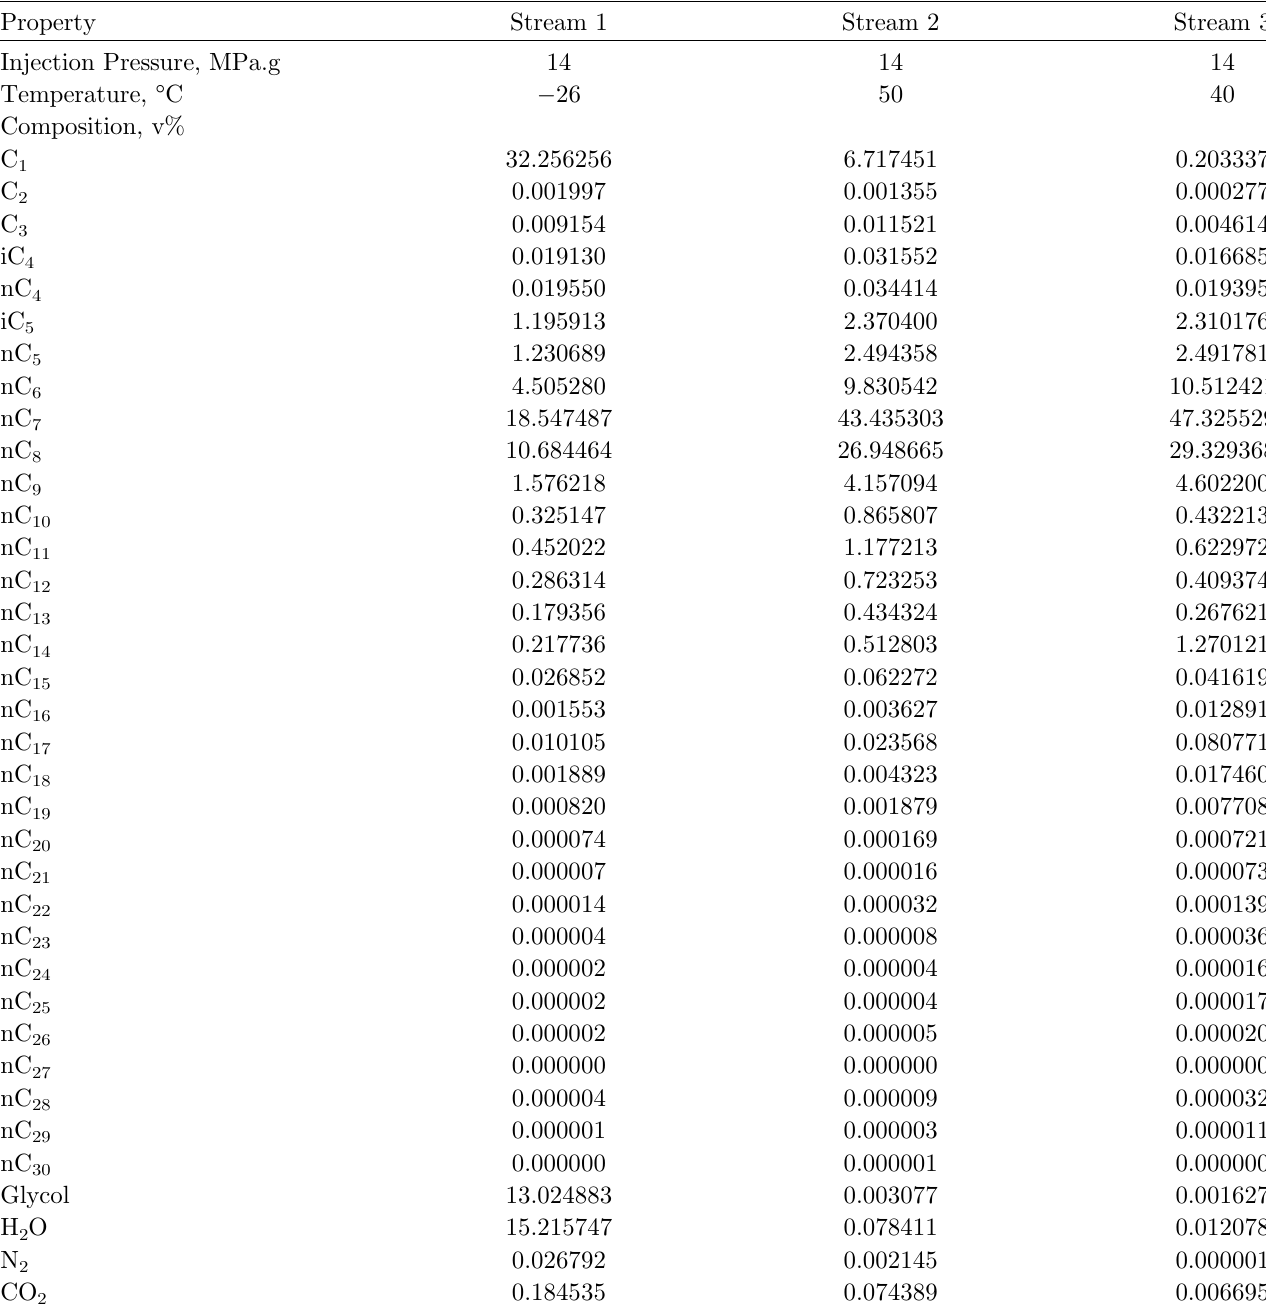
Table 3. The conditions and composition of three streams.